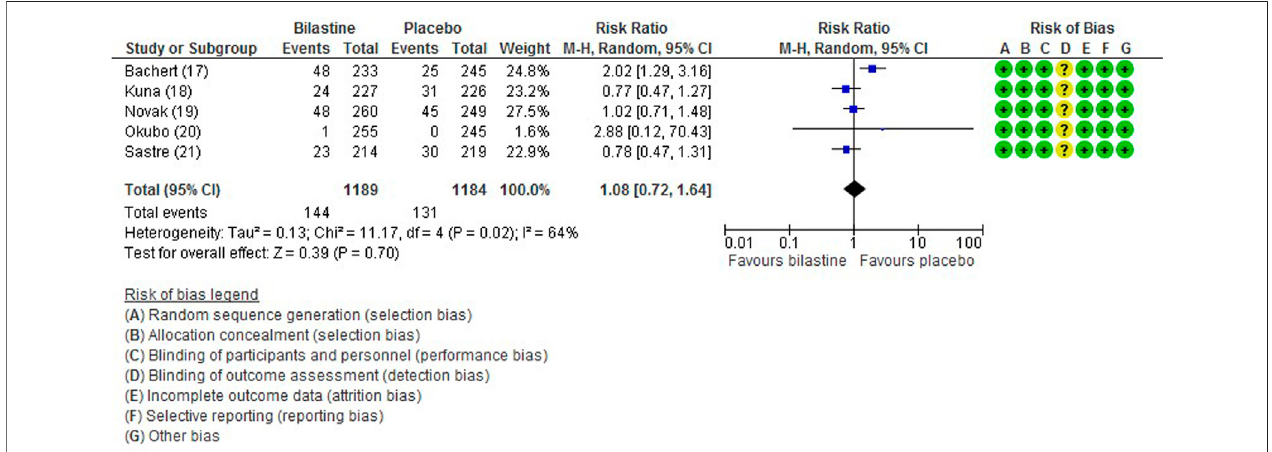
FIGURE 8 | Comparison between bilastine and placebo for headache. CI Con fi dence interval, df degrees of freedom.